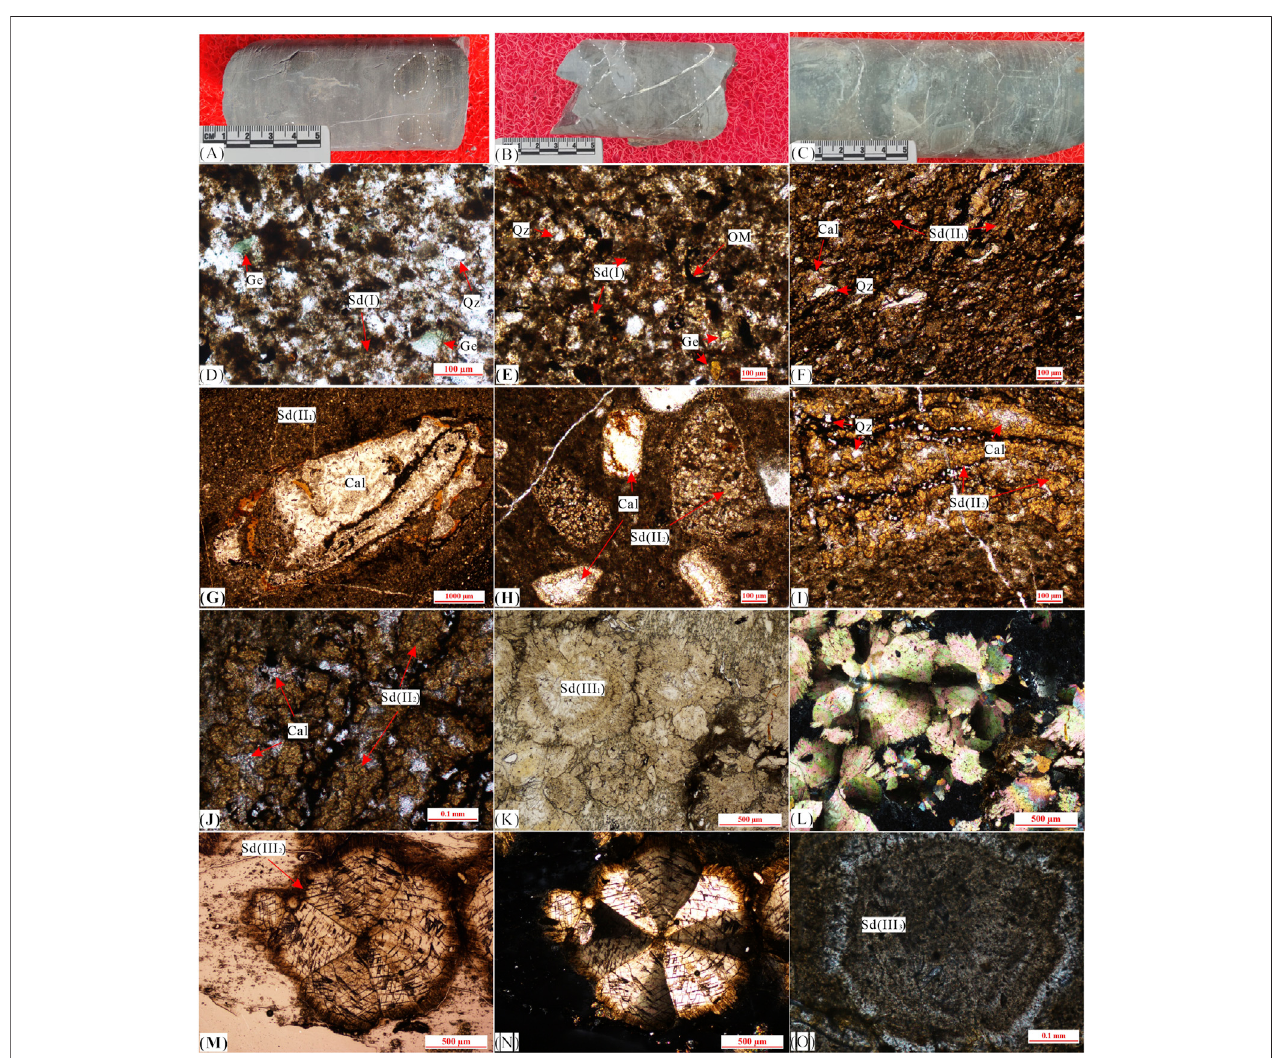
FIGURE 2 | Observation of drilling core and characteristics of siderites. (A) Siderite nodules and banded are discovered in the gray – black mudstone, J-3. (B) Siderite is lenticular and irregular agglomerated in the silty mudstone, J-7. (C) Irregular and banded siderite, J-11. (D) Gelatinous siderite mixed with clay minerals, showing angular glauconite, Y-3. (E) Gelatinous siderite is aggregated, and pyrite is locally developed, J-1. (F) Microlite siderite aggregate, evenly distributed, J-5. (G) Microlite siderite and powder crystal siderite are recrystallized around the shell of paleontology, J-13. (H) The paleontological shell is recrystallized into powder crystalsiderite,J-14. (I) Powdercrystalsiderite,withlargegrainsanddevelopedtopetal-likesiderite,J-17. (J) Powdercrystalsideriteisrecrystallizedaroundcalcite,and some are developed to petal-like siderite, Y-8. (K) Petal-like siderite, lane-polarized light, Y-2. (L) Cross-polarized light of “ K. ” (M) Radiating fi brous siderite, lane- polarized light, Y-4. (N) Cross-polarized light of “ M. ” (O) Concentric siderite, lane-polarized light, J-4. Sd, siderite; Qz, quartz; Ge, glauconite; OM, organic matter; Cal, calcite.